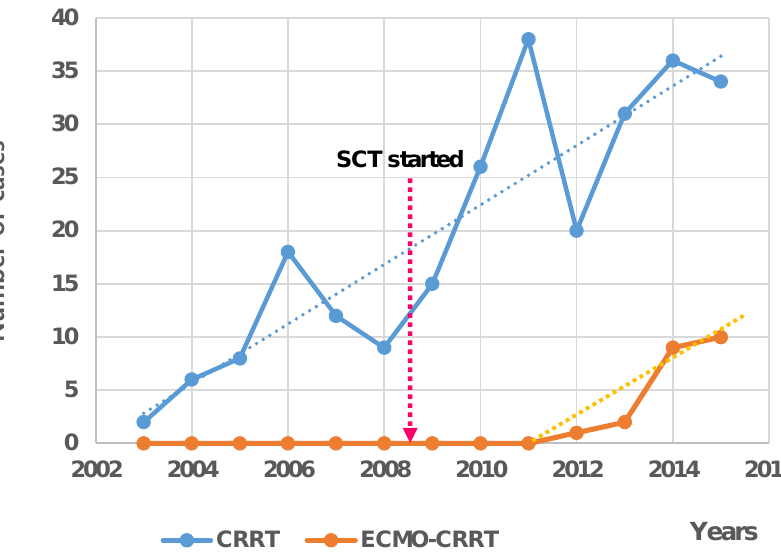
Figure 1. Distribution of CRRT and ECMO-CRRT numbers according to the years